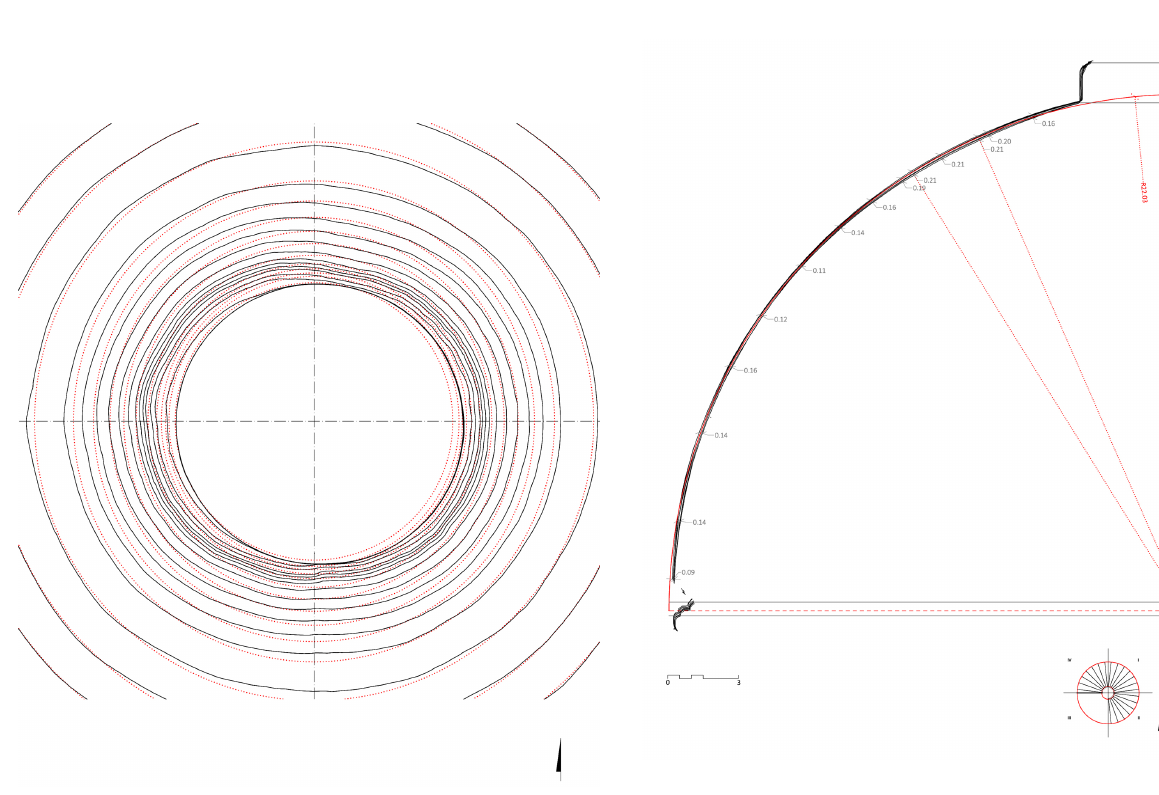
Figure 7. Study of the profile view of the dome by rotating the Figure 6. Horizontal sections of the upper area of the intrados meridian sections of a quadrant of the dome in the same of the dome: comparison between the survey model (black) and the ideal model (red).